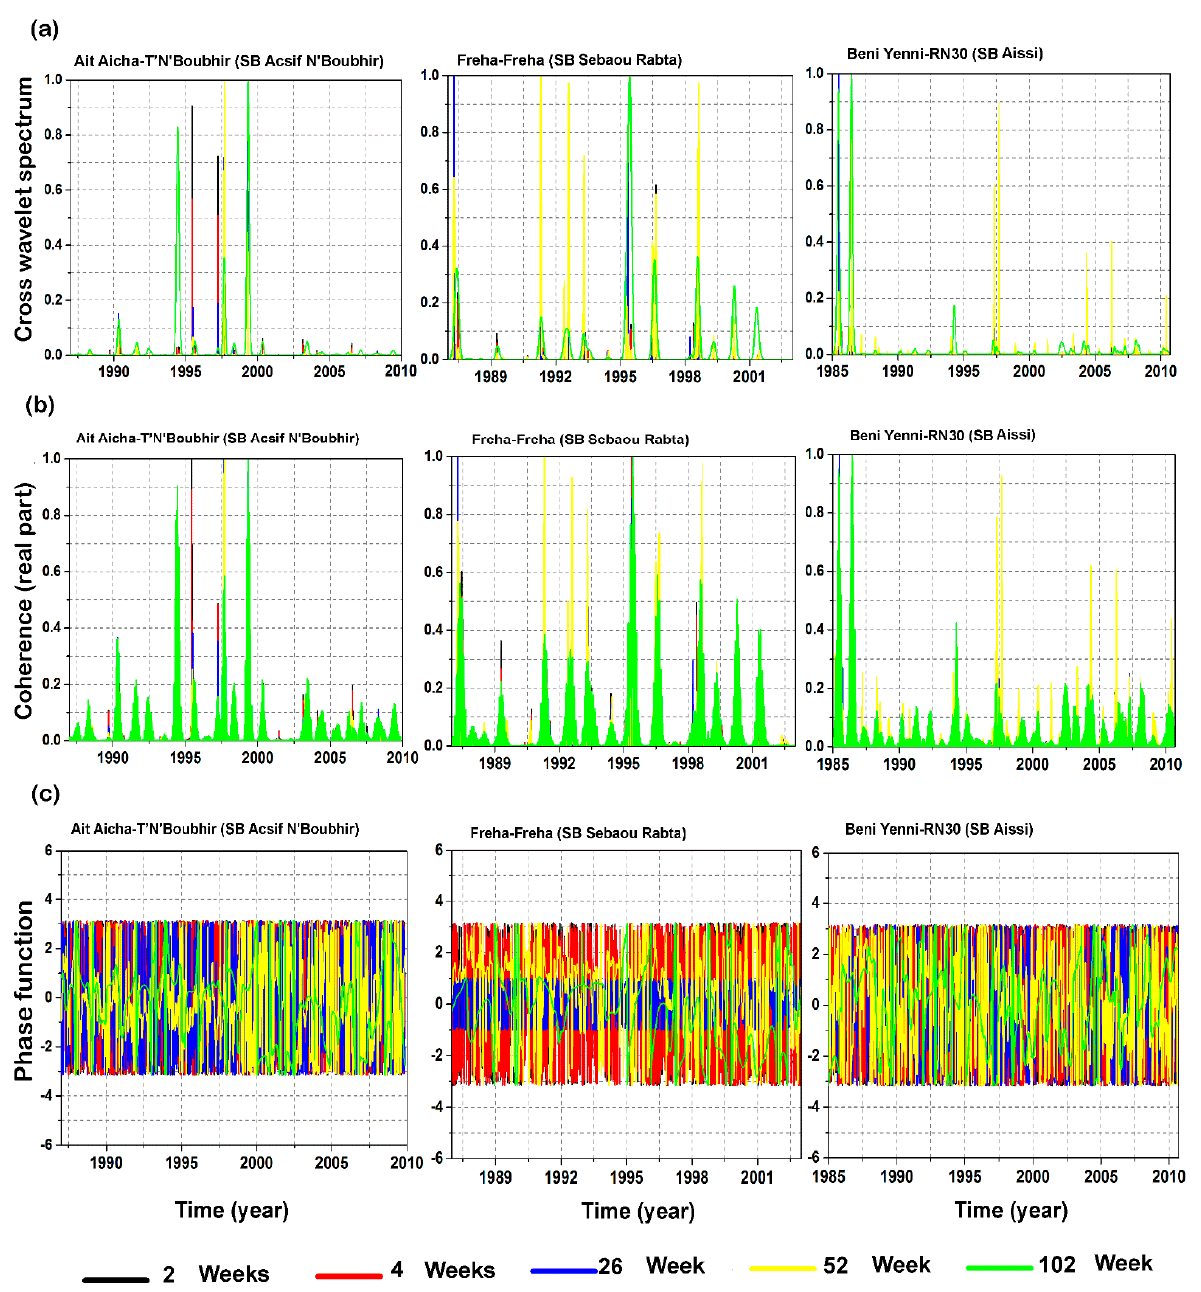
Figure 10. Representation analyses of ( a ) cross wavelet spectra, ( b ) square real part coherence spectra, and ( c ) phase function spectra between daily rainfall and streamflow for three representative sub-basins of the Sebaou River for the different isolation components of short-, medium- and long-term processes.